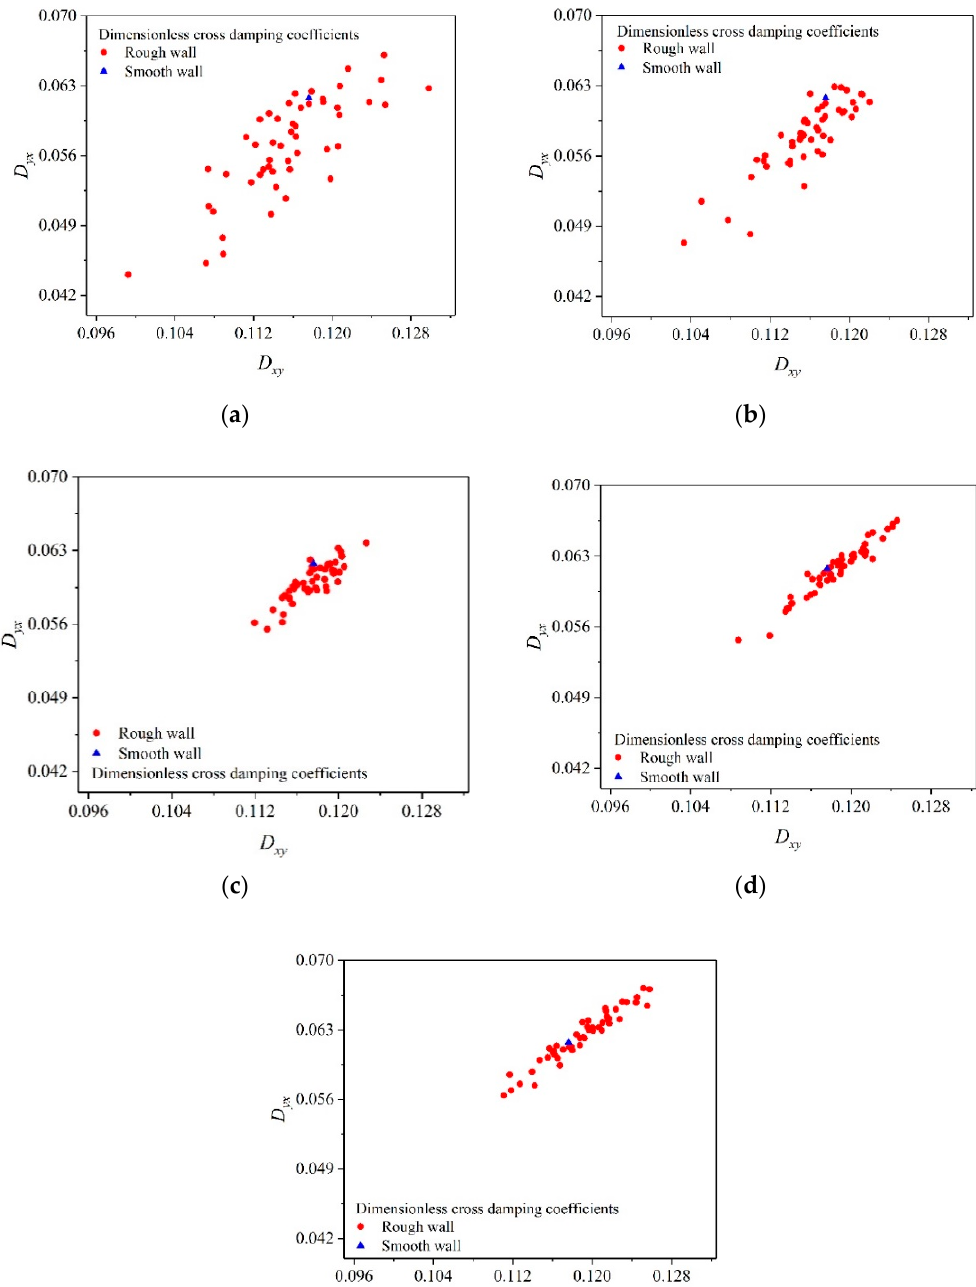
Figure 12. Cross damping coefficients distribution with wear in axial regions. ( a ) axial region 1. ( b ) axial region 2. ( c ) axial region 3. ( d ) axial region 4. ( e ) axial region 5.